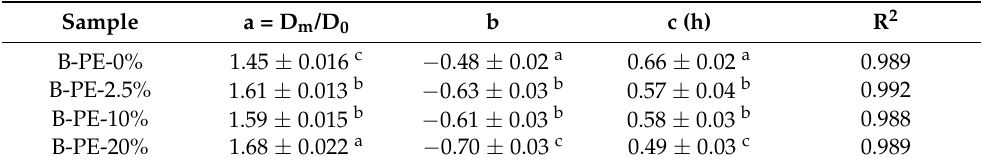
Table 2. Parameters of Equations (7) and